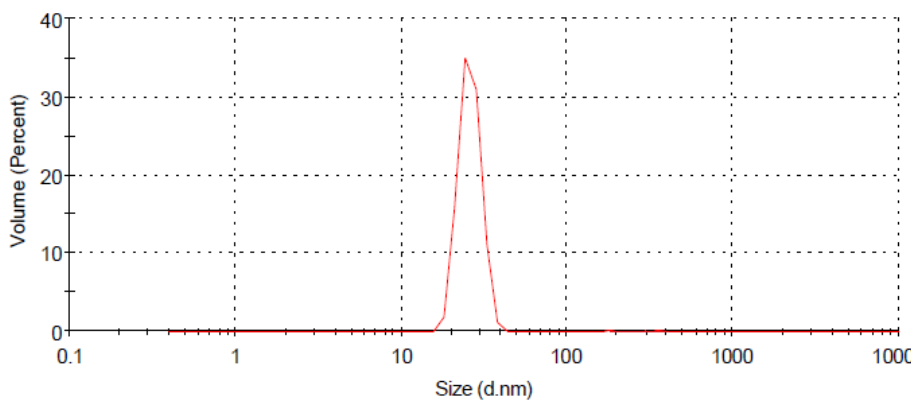
Figure 2. Z average size of curcumin nanoparticles.